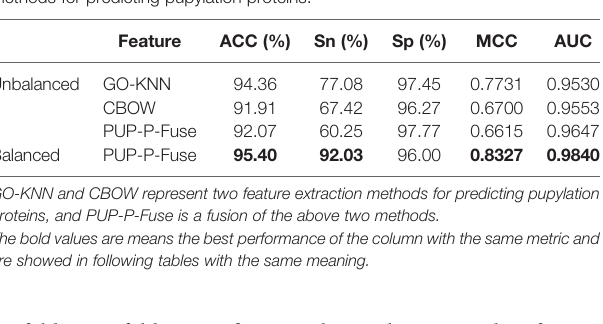
10-fold cross-folding veri fi cation, the prediction results of ACC, Sn, Sp, MCC, and AUC on balanced and unbalanced data sets were obtained and are shown in Table 2 .